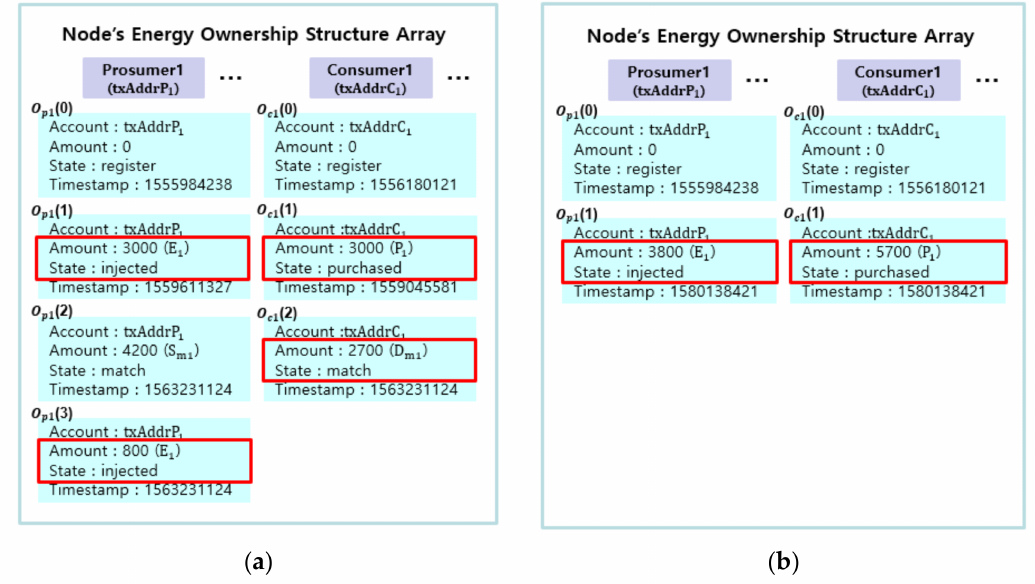
Figure 7. Example of aggregation of multiple elements: ( a ) Before aggregation and ( b ) after